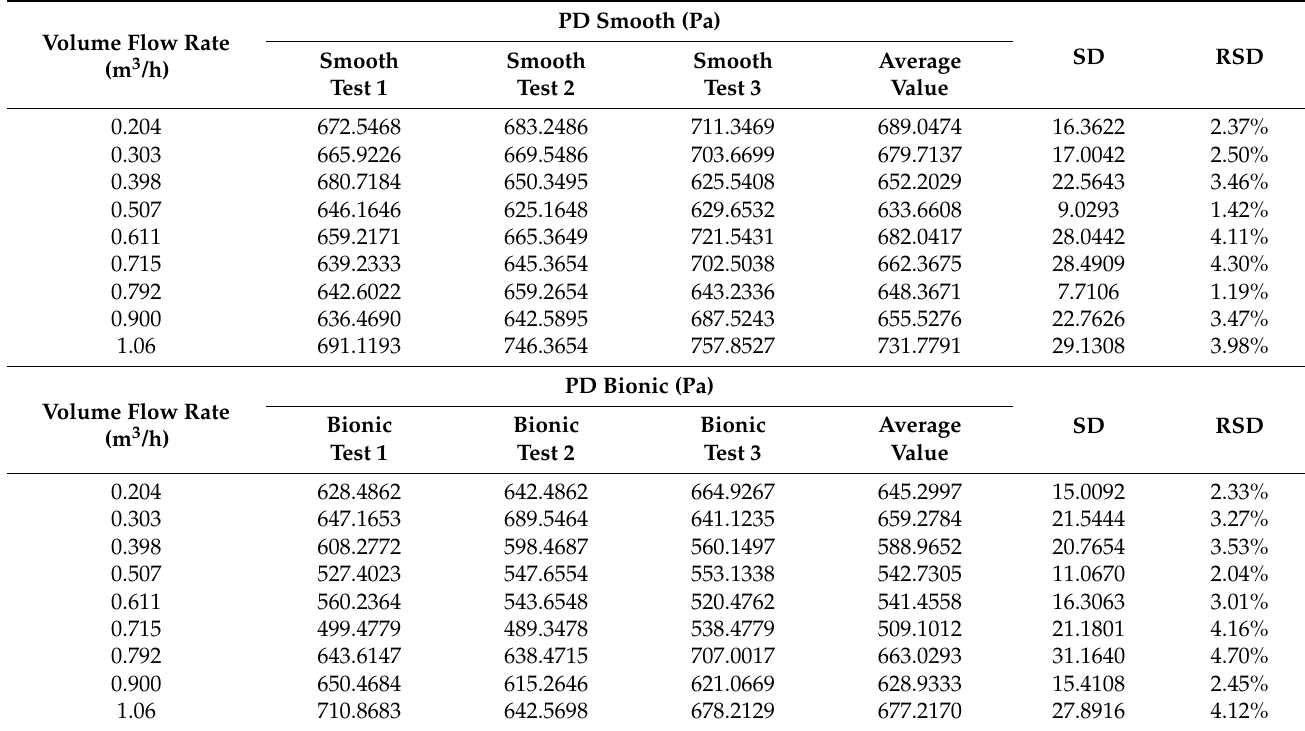
Table 2. Channel test